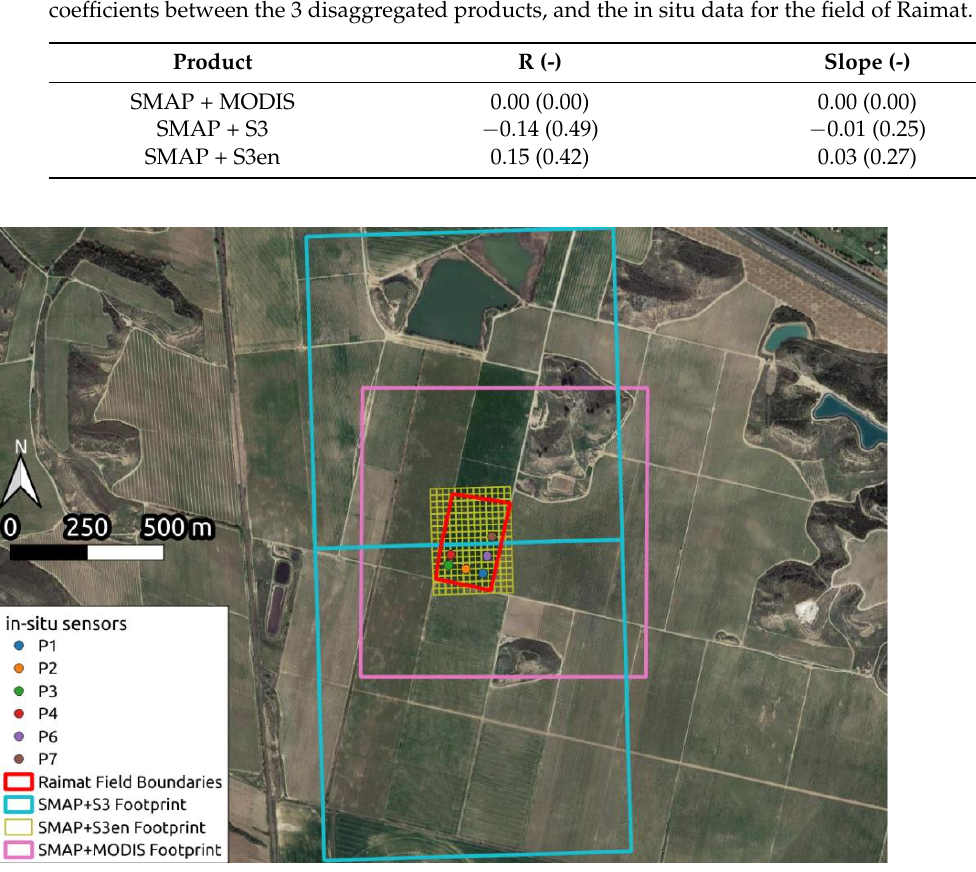
Figure 7. Spatial analysis for the field in Raimat. ( a ) Footprints of the different pixel sizes of the product used. For the case of SMAP + MODIS (pink), a single pixel covers the entire area, showing the same value for the six different sensors, while in the case of SMAP + S3 (cyan) the sensor in position P7 is covered by a different pixel. SMAP + S3en (yellow) has a finer resolution where each pixel covers a different sensor. The six points representing the sensors’ positions have been magni- fied for the sake of visibility, each of them is actually contained in a 20 m by 20 m SMAP + S3en pixel. ( b ) Spatial correlation for each available day for the 3 different products, SMAP + MODIS, SMAP+S3 and SMAP + S3en.